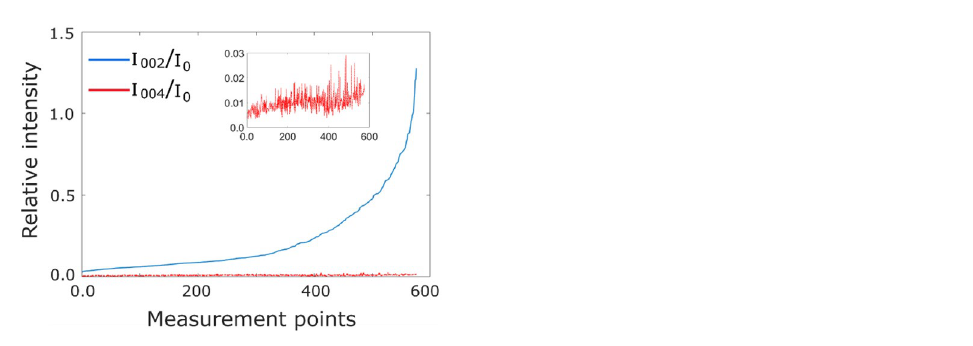
Figure 5. The quantities I 002 /I 0 and I 004 /I 0 are plotted together in an order from the lowest to the highest values of I 002 /I 0 . The intensities are extracted from a 4D diffraction data